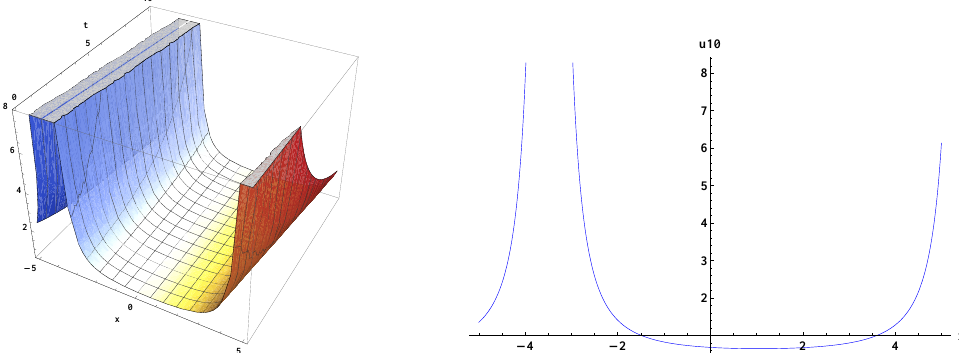
Figure 10. Singular periodic wave solution (27) ( left ) and its projections at t = 0 ( right ), when A 1 = 0.4, A 2 = 0.9, µ = 0.4, λ = − 0.3, k = 0.1, δ = 1, and y = 0.5.